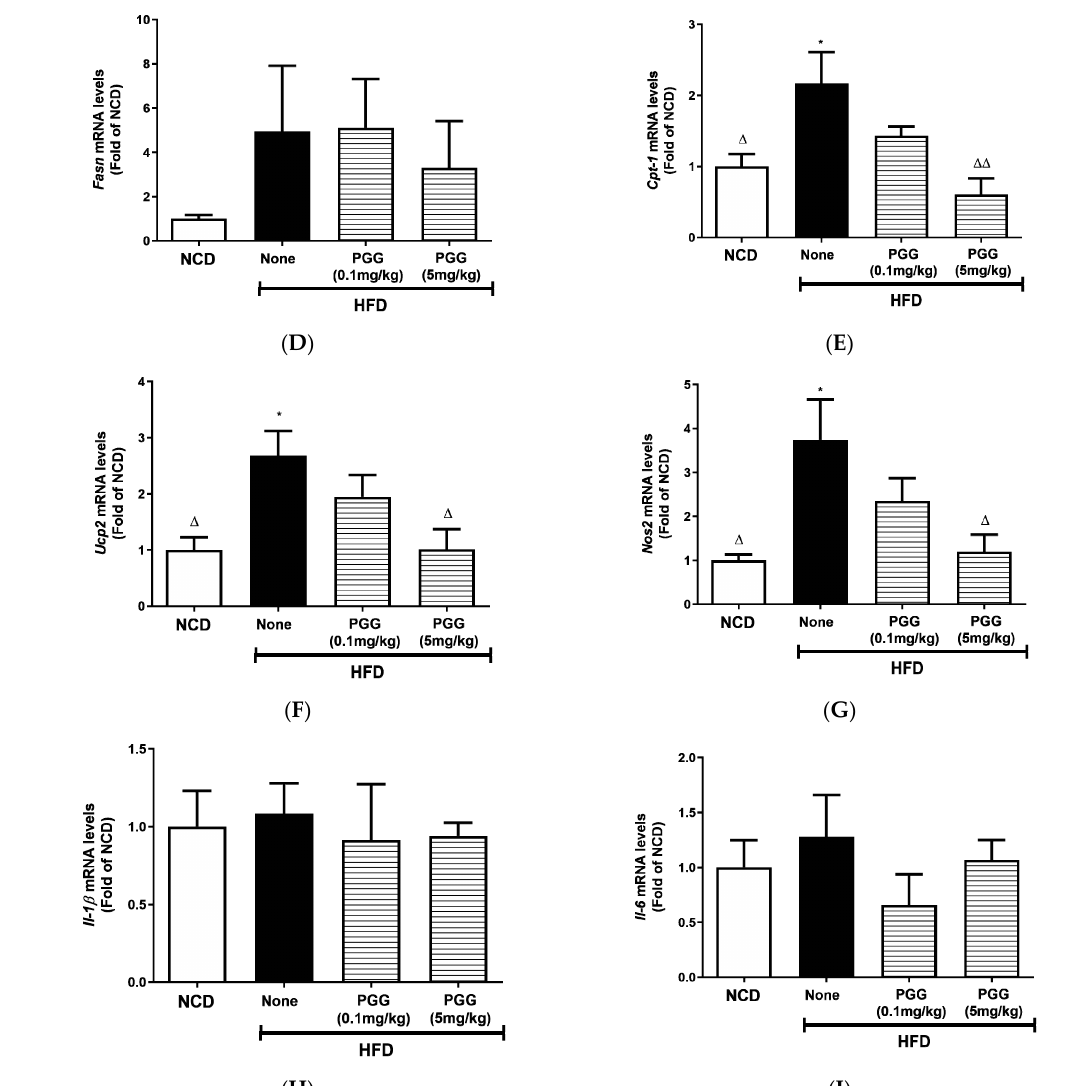
Figure 5. Effect of 12 weeks of β -PGG supplementation on diet-induced hepatic steatosis and gene expression in DIO mice. ( A ) Images of haematoxylin–eosin-stained liver tissue, ( B ) liver weight, ( C ) hepatic liver TG content and gene expression of ( D ) fatty acid synthase ( Fasn ), ( E ) carnitine palmitoyltransferase 1 ( Cpt-1 ), ( F ) mitochondrial uncoupling protein 2 ( Ucp-2 ), ( G ) nitric Oxide Synthase 2 ( Nos2 ), ( H ) interleukin 1 beta ( Il-1 β ), and ( I ) interleukin 6 ( Il-6 ). Data are shown as mean ± SEM. ( n = 4) * p < 0.05, ** p < 0.01 and *** p < 0.001 compared with control diet (NCD) group. ∆ p < 0.05 group, ∆∆ p < 0.01, and ∆∆∆ p < 0.001 compared with HFD (none) group.